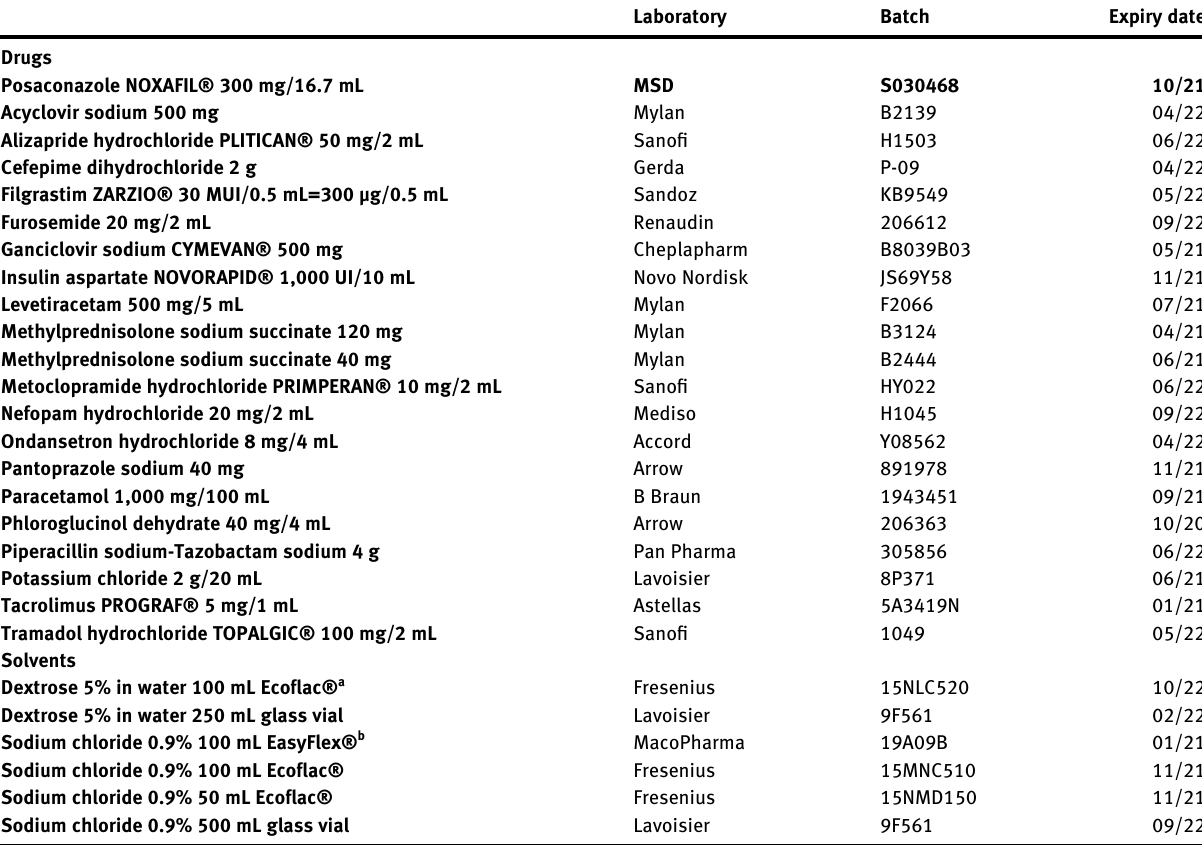
Table  : List of injectable drugs used for laboratory tests.